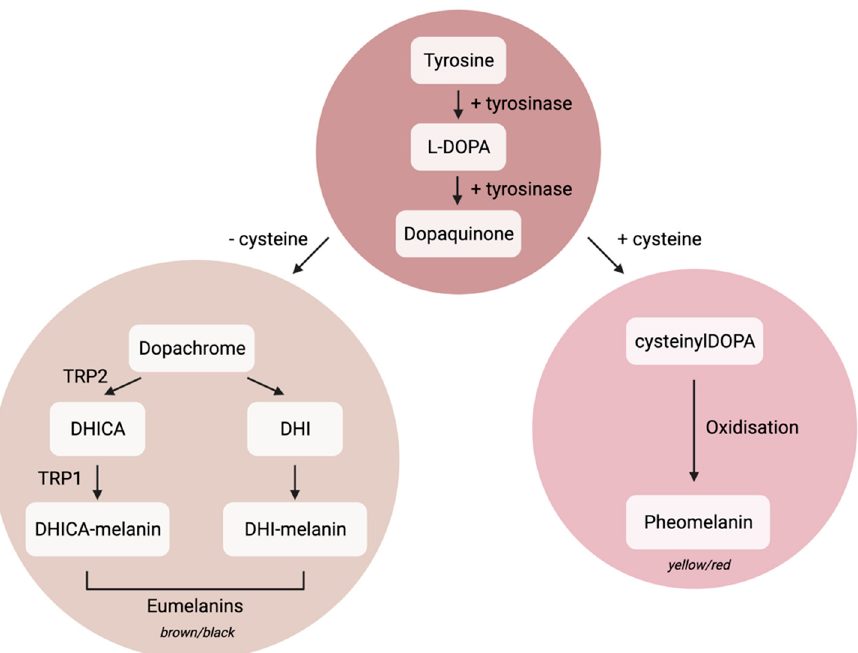
Figure 1. Eumelanin and pheomelanin production. Adapted from Cichorek et al., 2013 [5]. Tyrosine is converted to levodopa (L-DOPA) and dopaquinone by the enzyme tyrosinase. Here, the pathway diverges dependent on the presence of cysteine to form either brown/black eumelanins or yellow/red phenomelanins. During eumelanin production, dopachrome can be converted to 5,6-dihydroxyindole-2-carboxylic acid (DHICA) melanin, facilitated by the presence of tyrosinase-related proteins 1 and 2 (TRP1 and TRP2). To form pheomelanin, cysteinylDOPA is oxidised. Melanocytes are intermittently mitotic cells, meaning they spend most of their life in a state of quiescence [15]. Upon signalling from neighbouring keratinocytes, such as the release of mitogenic factors α -MSH, endothelins 1 and 3, and basic fibroblast growth factor, melanocytes can resume the cell cycle [16,17]. In culture, mitogens, such as the phorbol ester phorbol-12-myristate-13-acetate (PMA), increase the proliferative capacity of melanocytes, allowing for a higher number of experimental cell stocks [18]. Interestingly, exosomes derived from keratinocytes are also capable of promoting melanocyte prolifera- tion, tyrosinase activity, and melanin synthesis, while fibroblast-derived exosomes were unable to generate these consequences